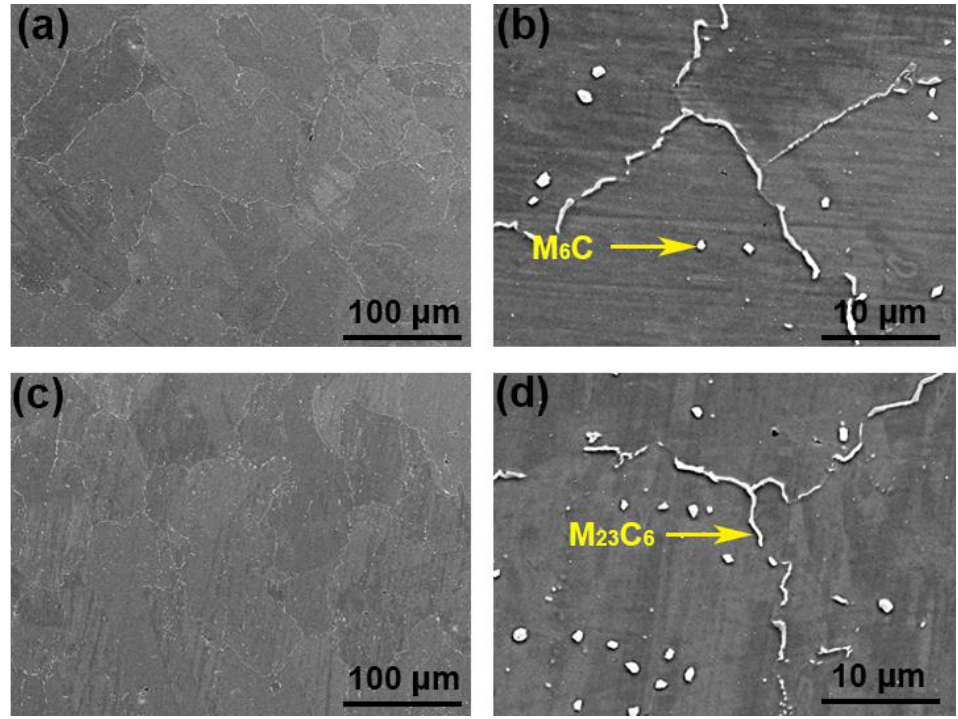
Figure 4. The SEM images of the SLM processed Haynes 230. ( a , b ) the vertical view of Haynes 230, ( c , d ) the horizontal view of Haynes 230.